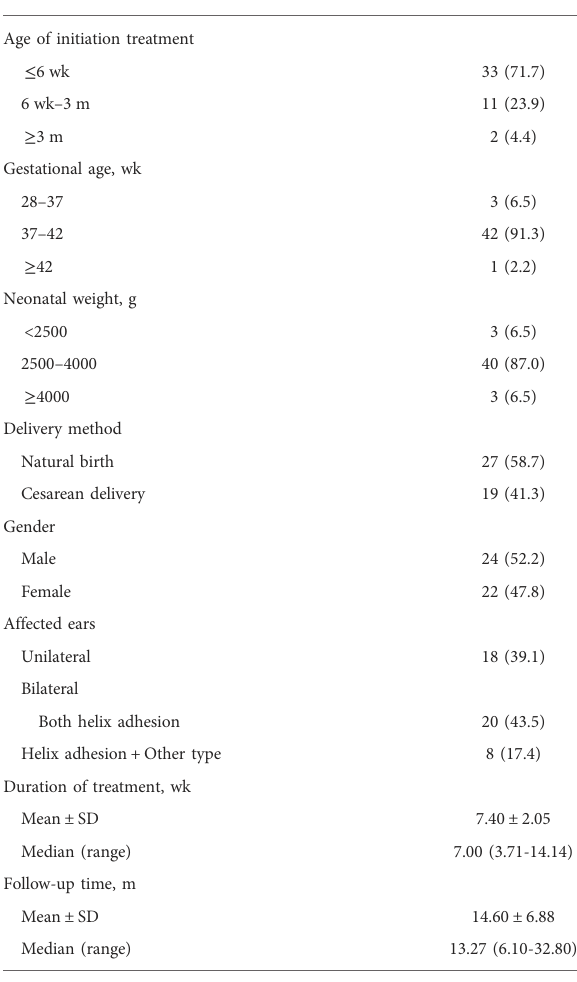
TABLE 1 Clinical characteristics of the 46 newborns with helix adhesion.